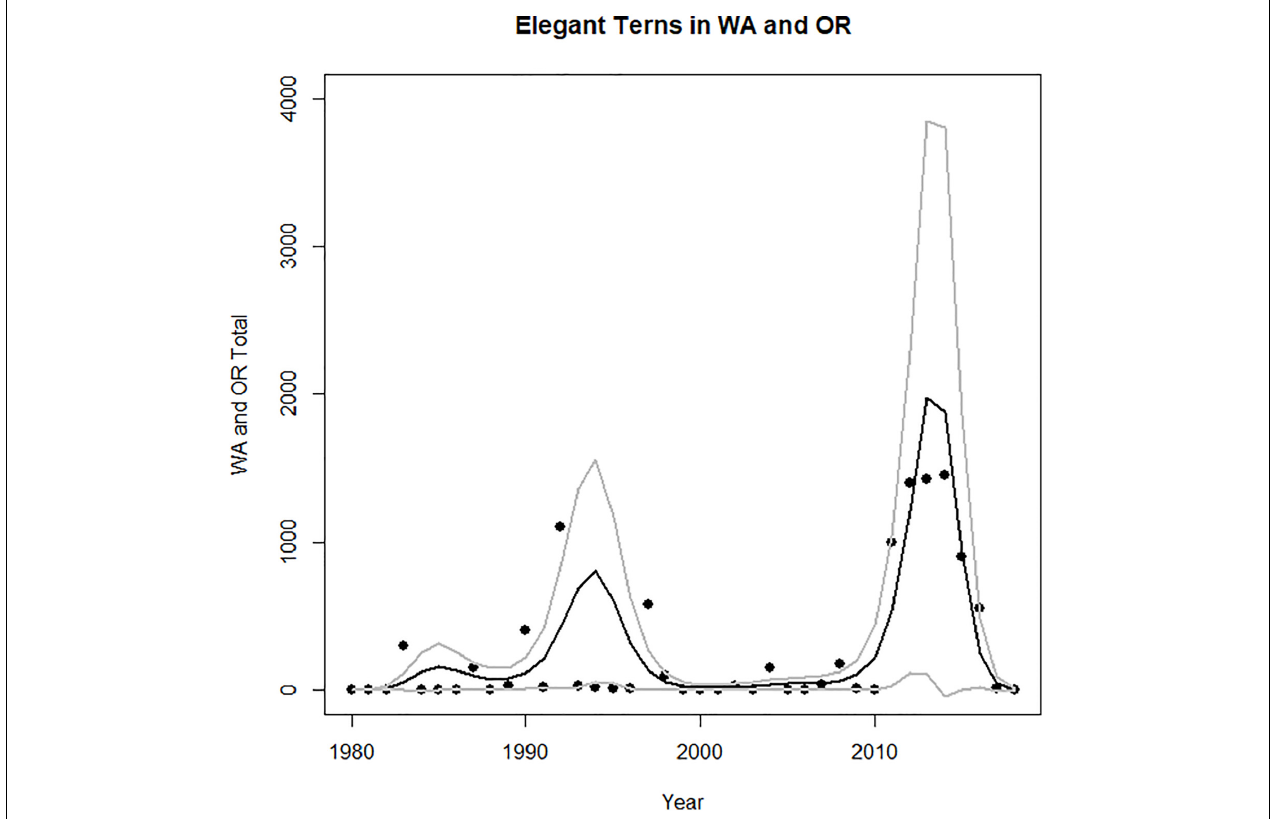
FIGURE 3 | Time series of abundance of vagrant elegant terns in Washington and Oregon during July–October. Fit of model improved with addition of data on Oceanic Niño Index ( Table 1 ). Predicted values and confidence limits